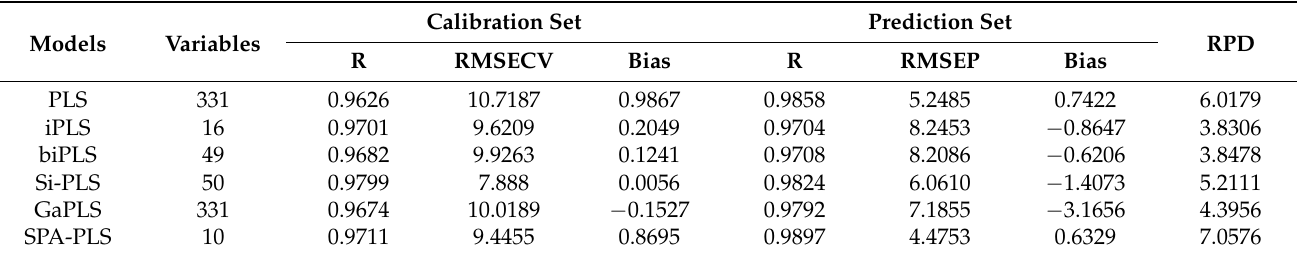
Table 3. Comparison of different PLS quantification